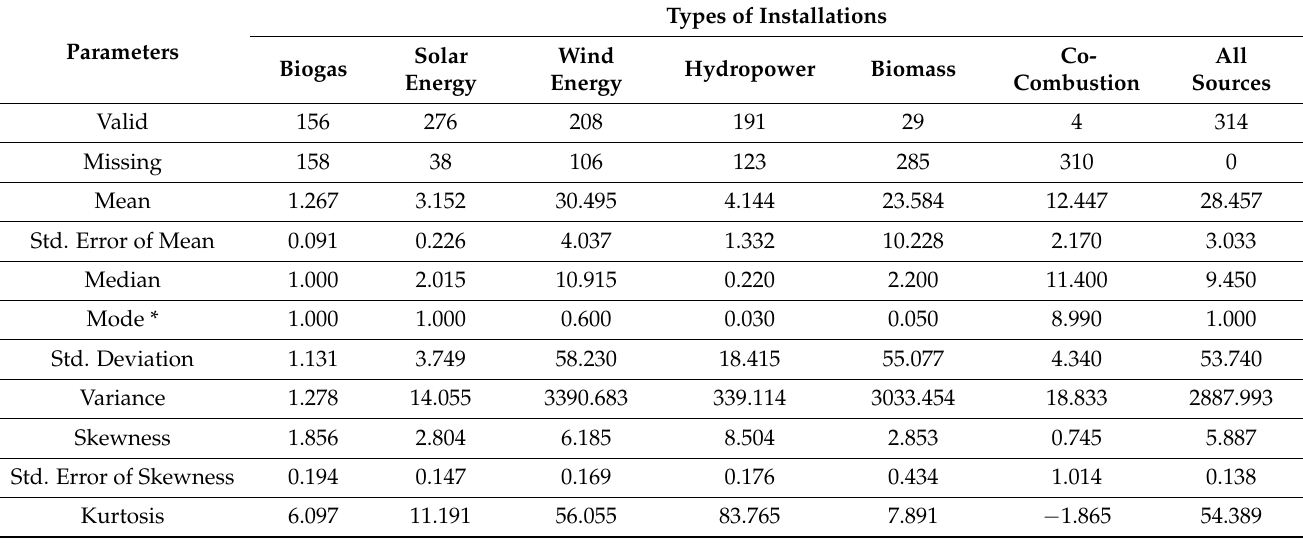
Table 2. Descriptive statistics for the analysis of renewable energy generation installations in Poland.